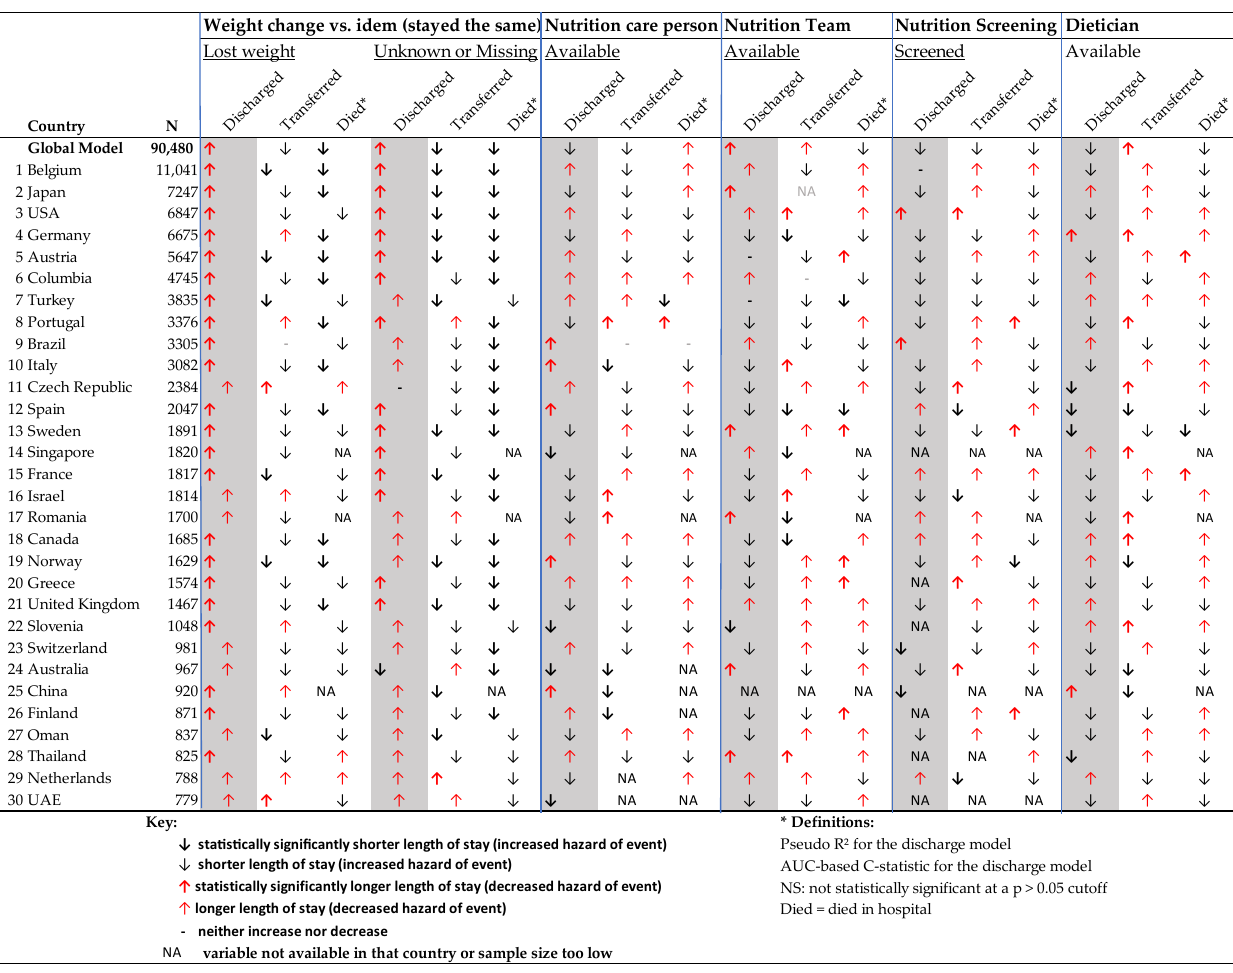
Figure 5. Nutrition-related determinants of length of stay (based on multivariable Cox proportional hazards competing risk country models).